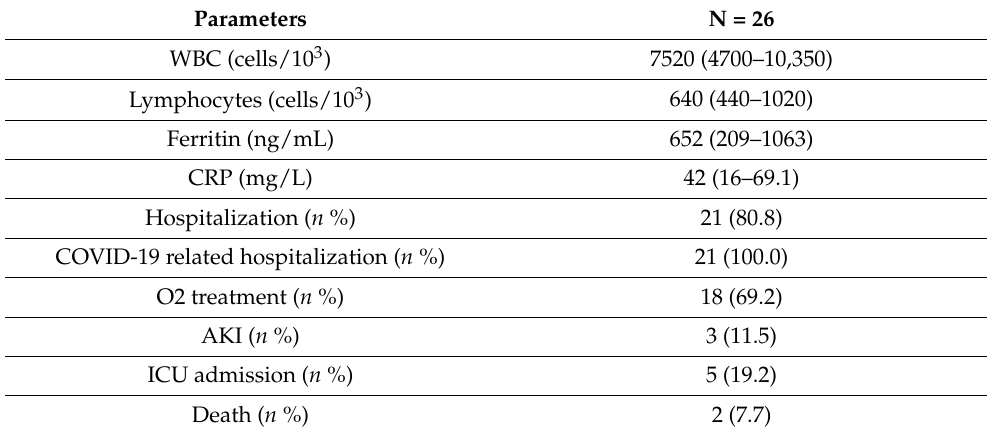
Table 5. Laboratory findings and outcomes of patients with moderate–severe